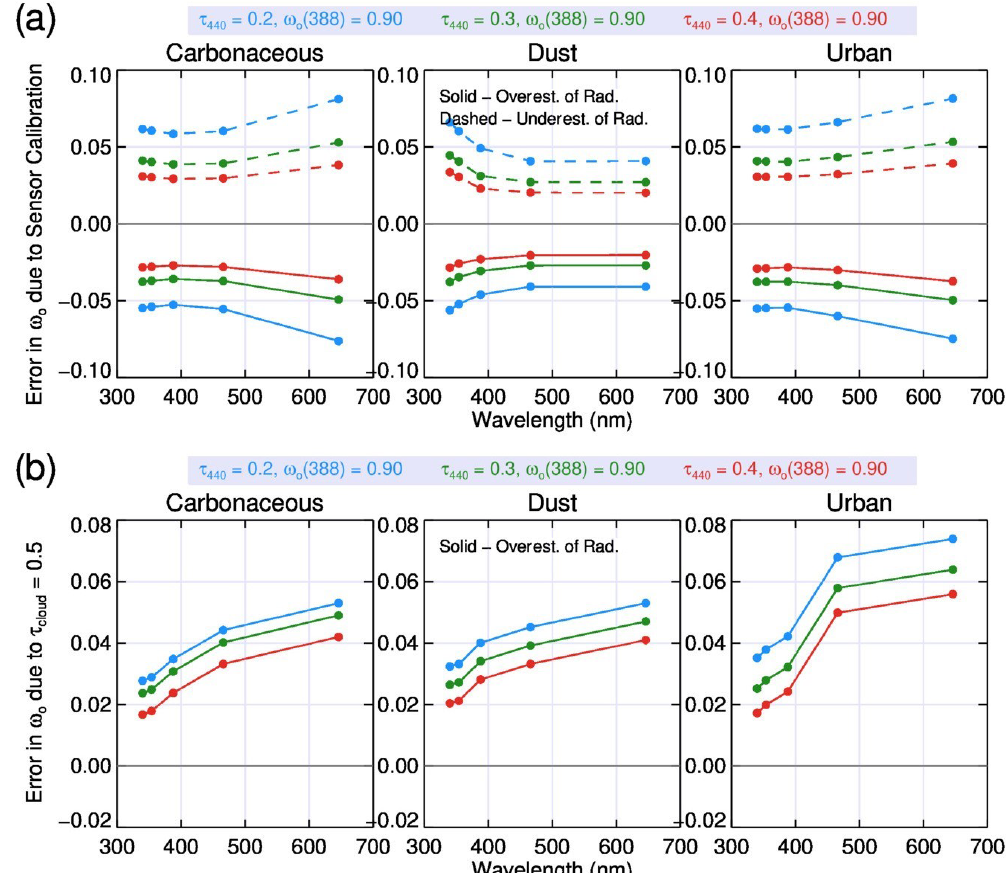
Figure 6. Theoretical uncertainty in SSA retrievals due to (a) ± 1 . 8% (OMI) and ± 1 . 9% (MODIS) sensor calibration and (b) cloud contam- ination ( τ cloud = 0 . 5). Solid and dashed lines represent the overestimation and underestimation of the corresponding input